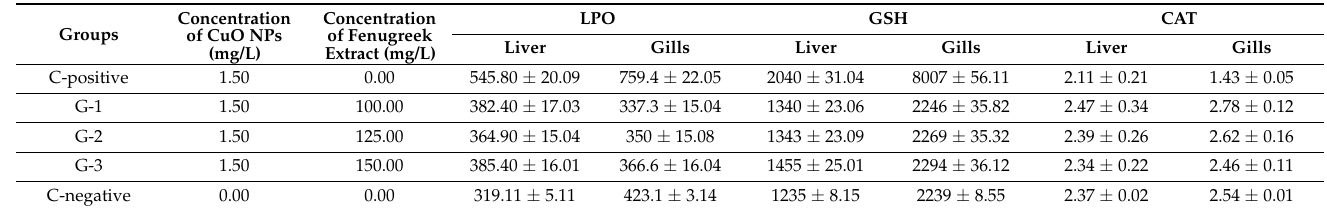
Table 7. Concentrations of different oxidative stress enzymes (lipid peroxidation (LPO) as nmol/mg protein of MDA; glutathione (GSH) as µ M/g of tissue homogenate; catalase (CAT) as unit per mg (U/mL) of tissue homogenate) in livers and gills of the common carp ( C. carpio ) experimentally exposed to CuO NPs and different concentrations of the fenugreek ( T. foenum-graecum ) extract for 28 days. Data are expressed as means ± standard error (SE; n =